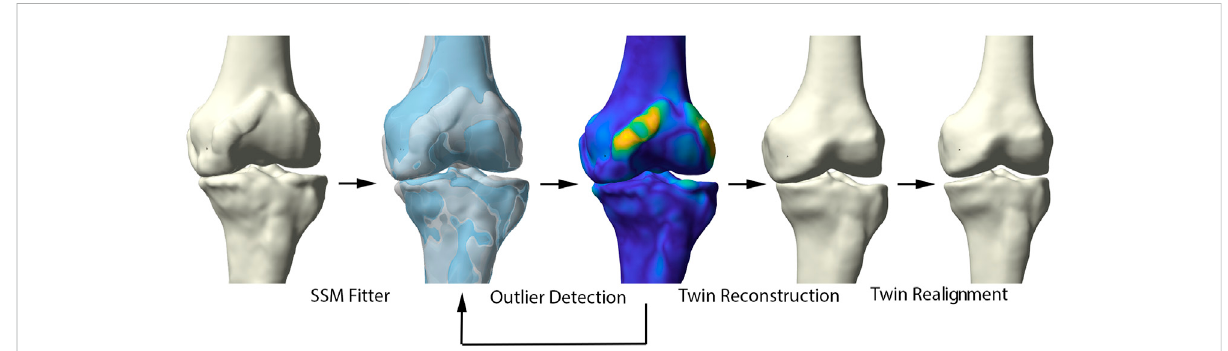
FIGURE 2 Representationofthehealthyvirtualtwinreconstruction.Lefttoright:startingfromadiseasedsample,healthyfemurandtibiawere fi ttedtothe arthritic knee. Outlier detection aided in osteophyte localization. Following, the healthy statistical shape model was fi tted to the diseased sample, excludingdiseaserelatedmorphologicalchanges.Thevirtualhealthytwinwasthenreassembledbasedonthehealthy,articulatedlowerlimbmodel.